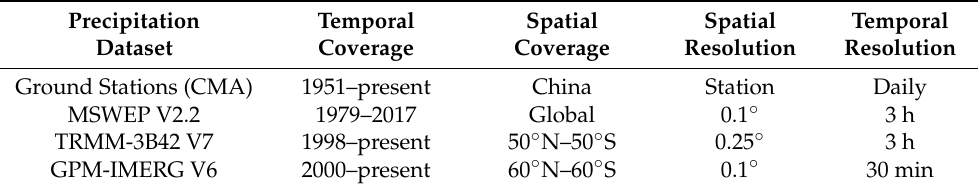
Table 1. General characteristics of the precipitation